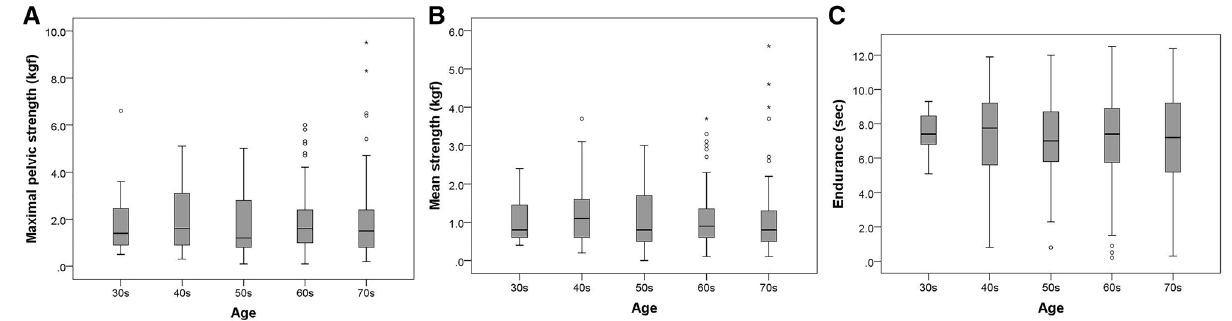
Figure 2. Box-and-whisker plots for maximal pelvic floor muscle strength ( A ), average strength ( B ), and endurance ( C ) based on age. The boxes show the interquartile range (IQR) with the median value expressed as a horizontal line, whiskers show the range of 1.5 × IQR. Circles indicate outliers and the asterisk indicates far outside